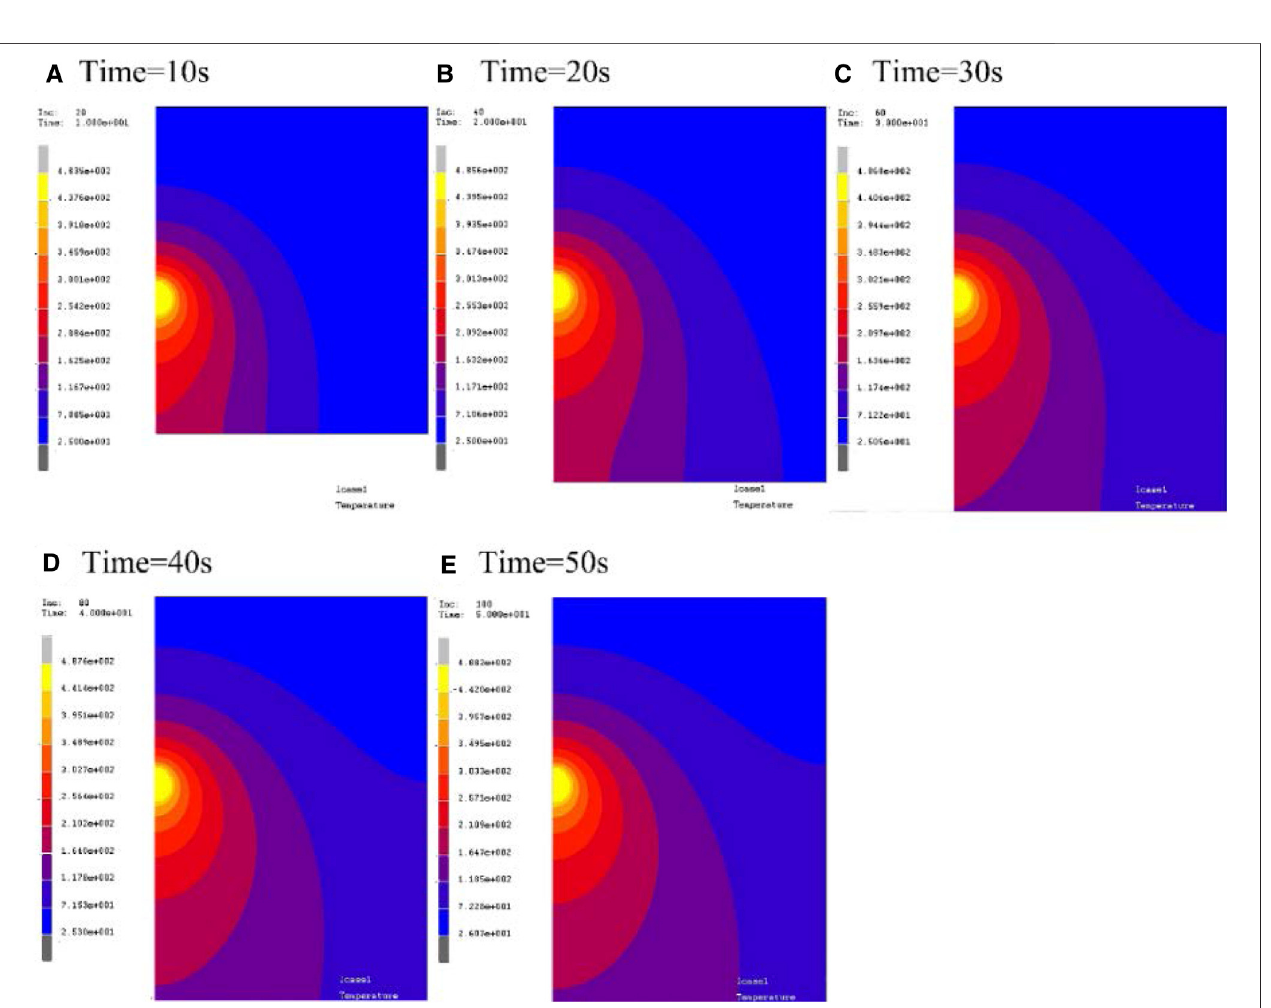
FIGURE3| Contouroftemperaturedistributionatdifferenttimeontheuppersurfaceoftheworkpiece(unit: ° C). (A) time=10s, (B) time=20s, (C) time=30s, (D) time = 40 s, (E) time = 50 s.